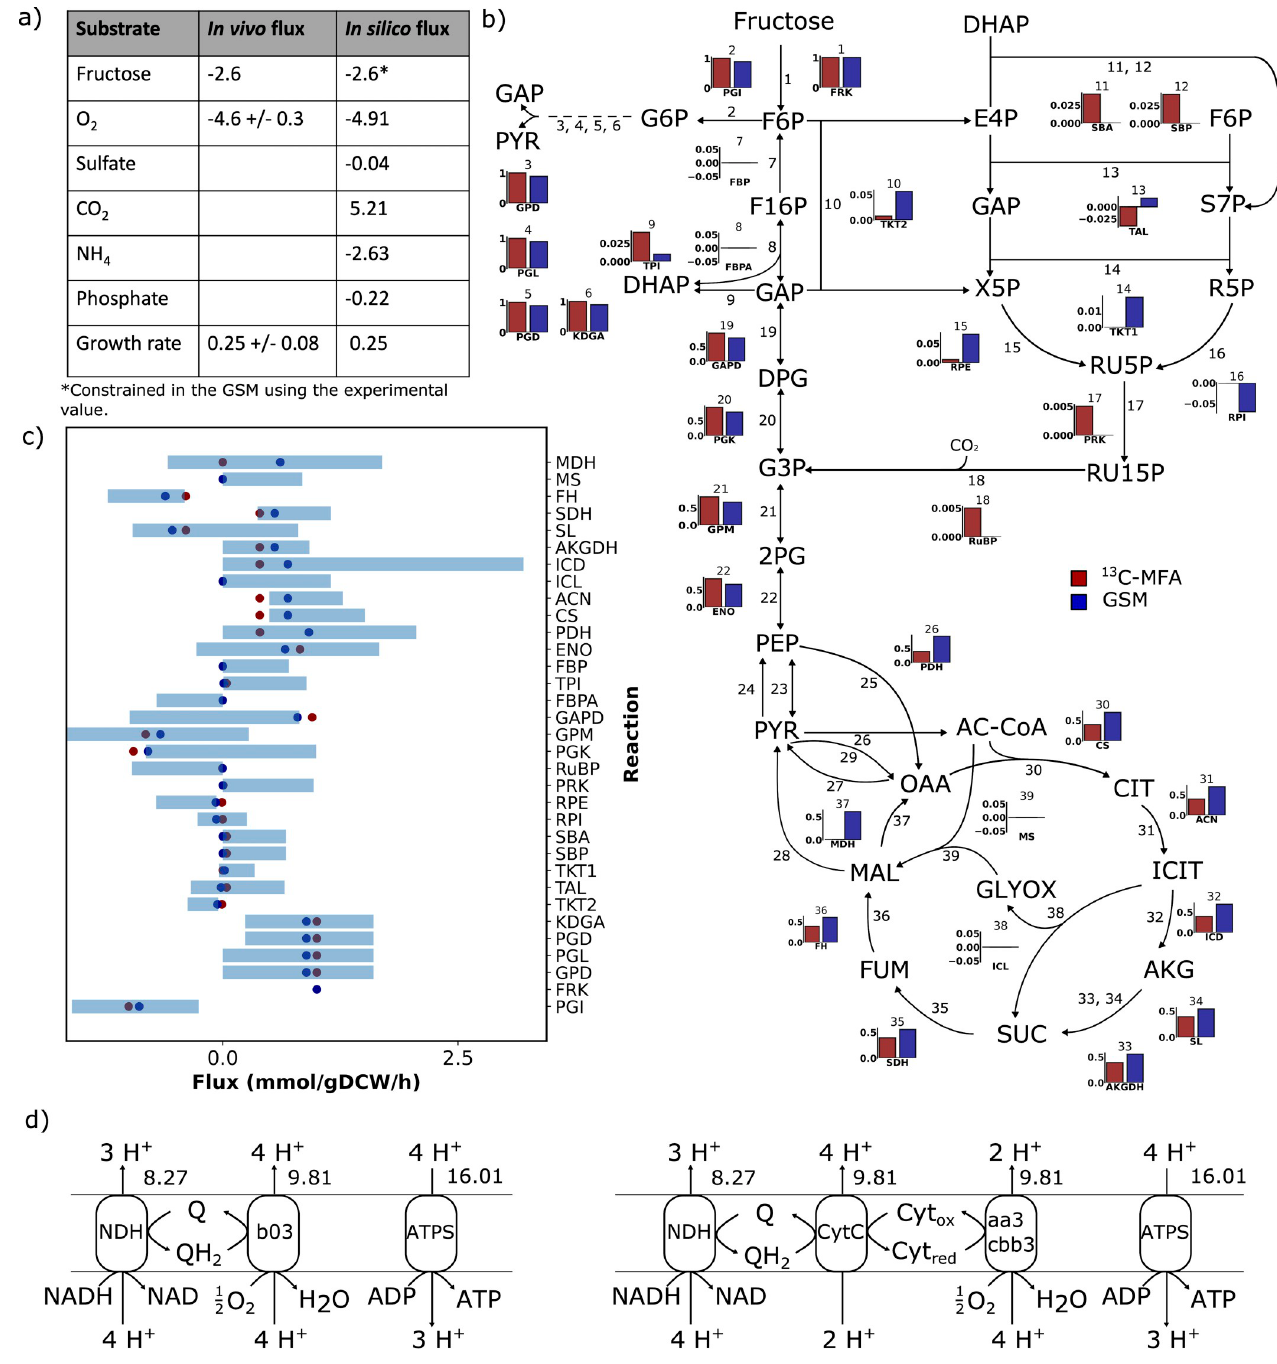
Fig 1. Experimental validation of central carbon metabolic fluxes for the i CN1361 GSM for growth on fructose. a) GSM prediction of substrate uptake rates and growth rate using i CN1361 for growth data provided in [9]. Units for the substrates are in mmol/gDCW/h, whereas the growth rate is h -1 . Note that the uptake rate of fructose was constrained in the model using the experimentally determined value. b) Comparison of the fluxes predicted by i CN1361 (blue bars) and 13 C metabolic flux analysis (red bars) for growth on fructose mineral media. The flux in the GSM have been normalised to correspond to a fructose uptake of 1 mmol/gDCW/h to allow comparison with the 13 C-MFA data. c) Minimum and maximum flux values for each reaction, calculated using flux variability analysis. Blue data points correspond to the pFBA flux prediction, whereas red dots correspond to the 13 C-MFA flux prediction. d) Two feasible routes through the electron transport chain of C . necator H16 predicted using i CN1361 growing at the maximum growth rate. The flux units are all in mmol/ gDCW/h. See the abbreviations section for the metabolite and reaction names.